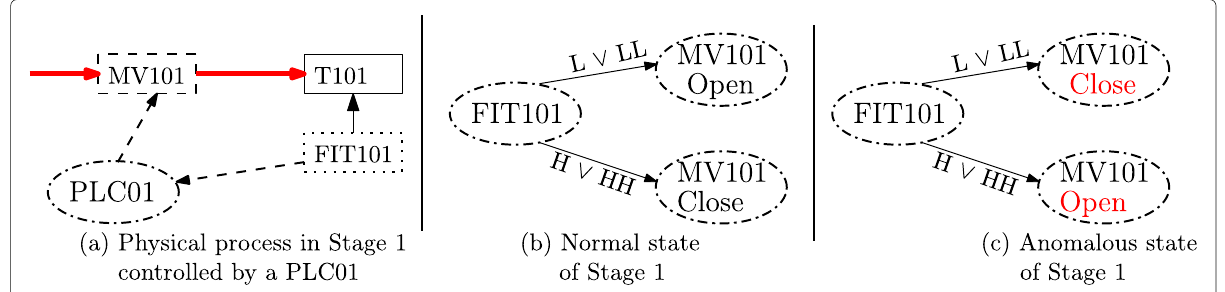
Fig. 5 Process graphs for Invariant #1 a Subsystem in stage one of SWaT; b a process graph for normal cases; c a process graph for anomalous cases